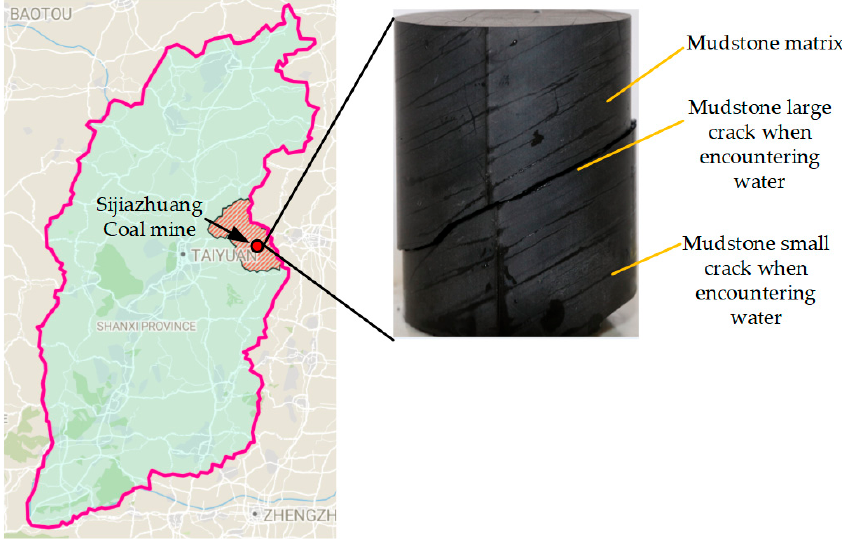
Figure 1. Location of the Sijiazhuang mine and a water decomposition diagram of mudstone.